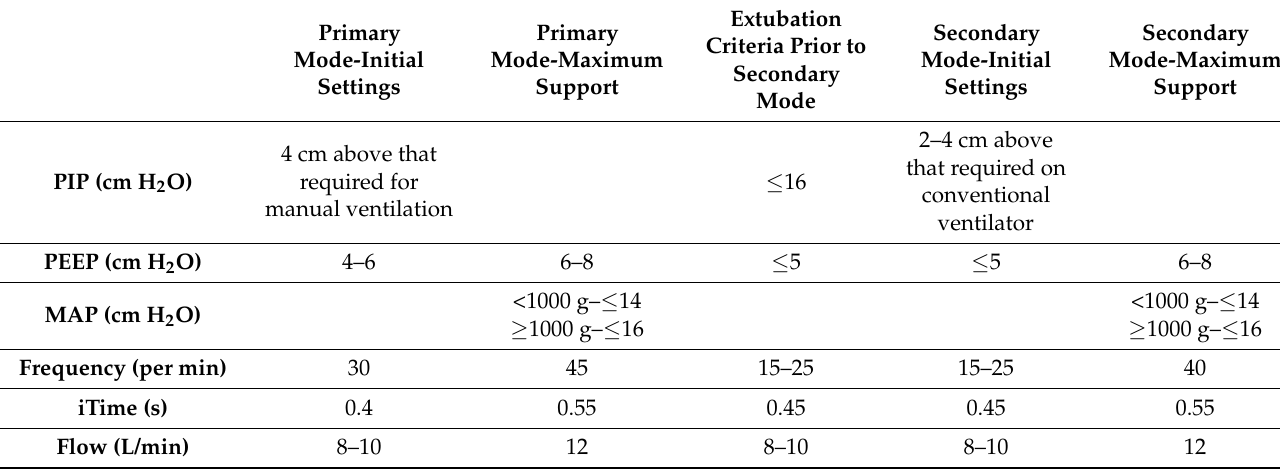
Table 1. Recommended initial and maximum support in primary and secondary modes with extubation criteria prior to secondary mode of nasal intermittent positive airway pressure